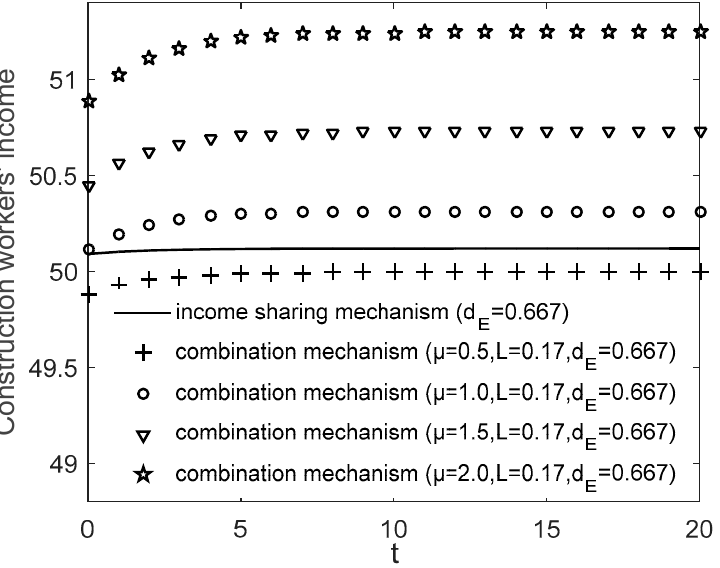
Figure 12. Construction workers’ income when 𝜇 takes different values under the combination mechanism.